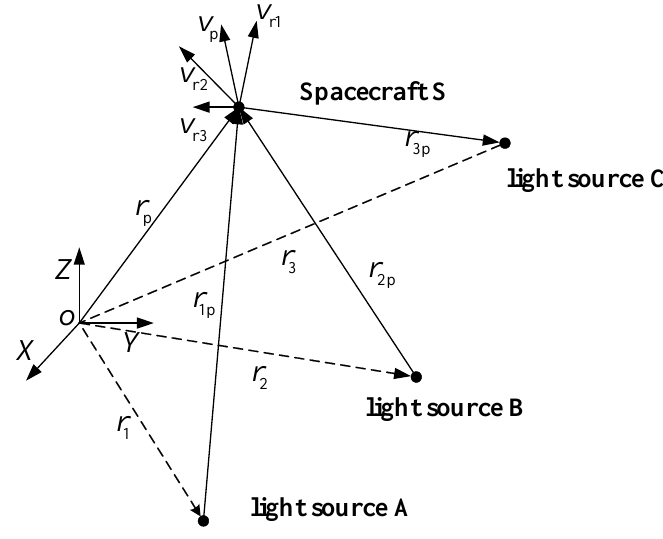
Figure 1. The principle of spectrum red-shift navigation.